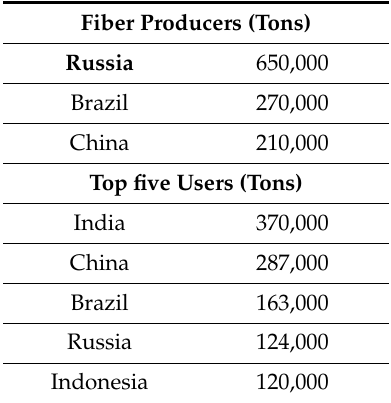
Table 1. Asbestos Trade Data